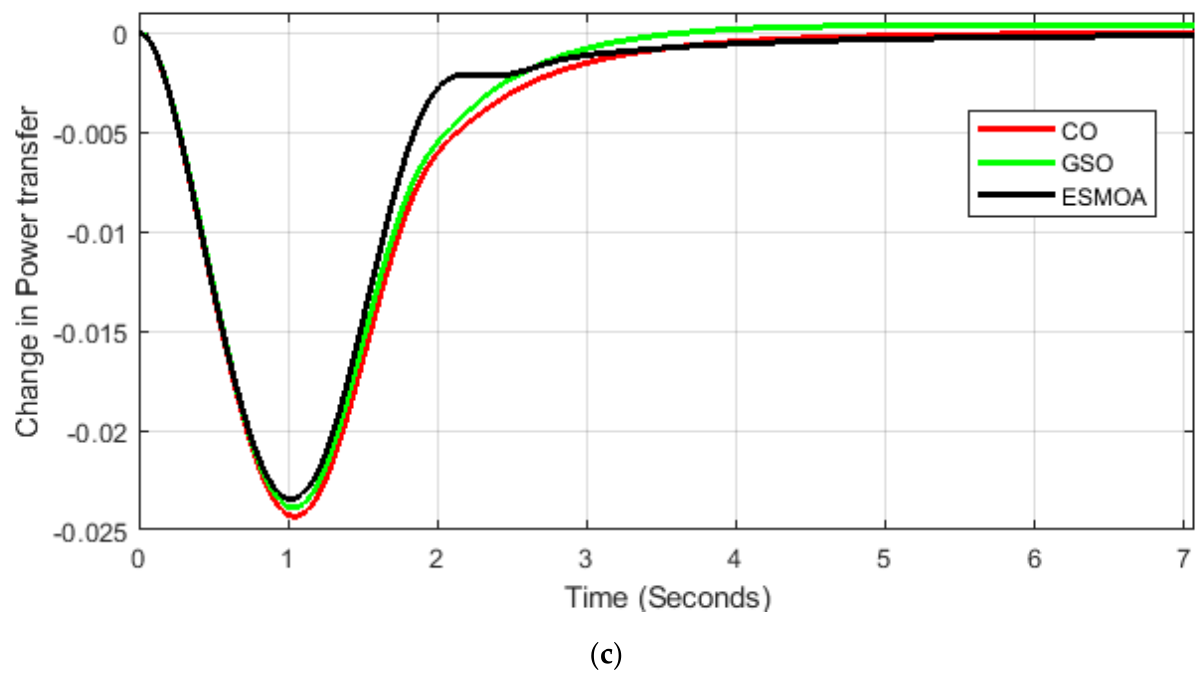
Figure 17. Dynamic responses for CO, GSO, and the proposed ESMOA for Case 4. ( a ) Deviation in frequency in area 1. ( b ) Deviation in frequency in area 2. ( c ) Deviation in transferred power through interconnected tie-line. Table 10 contrasts the efficacy of the proposed ESMOA-based PD-PI controller with various previously published controlling methods concerning ITAE. As shown, the pro- posed ESMOA-based PD-PI controller obtains the minimum ITAE of 0.225044, while the conventional PID, PID-based-GA, PID-based-BFOA, PID-based-FA, PID-based-hybrid FA and pattern search, CO-based PD-PI controller, and GSO-based PD-PI controller find 0.604, 0.5513, 0.4788, 0.324, 0.2782, 0.230348, and 0.25436, respectively. Table 10. Comparison of the proposed ESMOA outcomes with other reported results in terms of ITAE for Case 4.